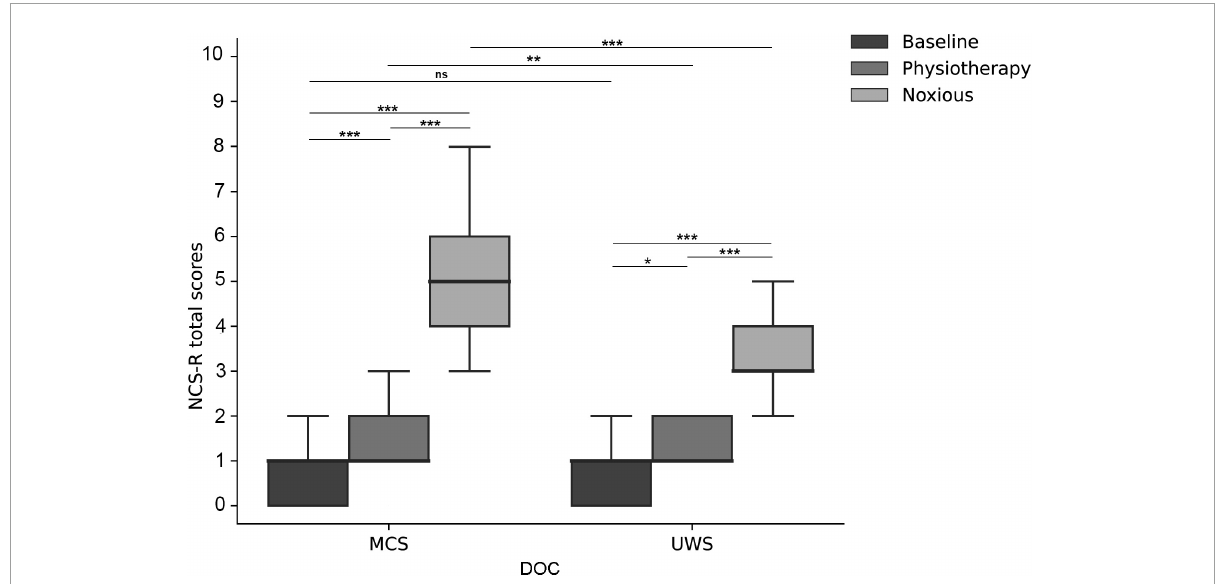
FIGURE1 Boxplot, patients’ NCS-R total scores with different stimuli (i.e., baseline, physiotherapy, and noxious stimulus) for all DOC patients, MCS patients, and UWS patients. * p < 0.05; ** p < 0.01; *** p < 0.001; ns, no significant difference; DOC, disorders of consciousness; UWS, unresponsive wakefulness syndrome; MCS, minimally conscious state; NCS-R, nociception coma